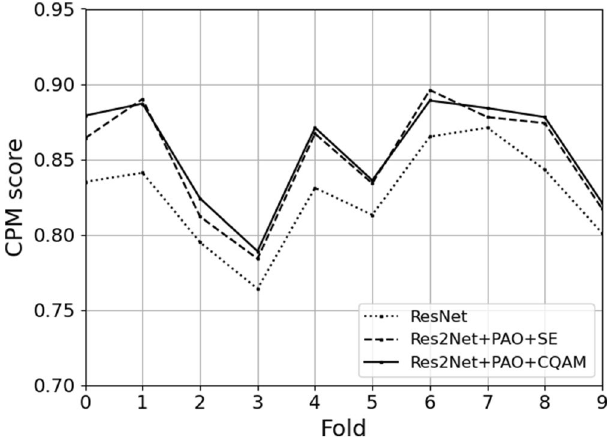
Figure 7. Detection results for each fold on the LUNA16 dataset.